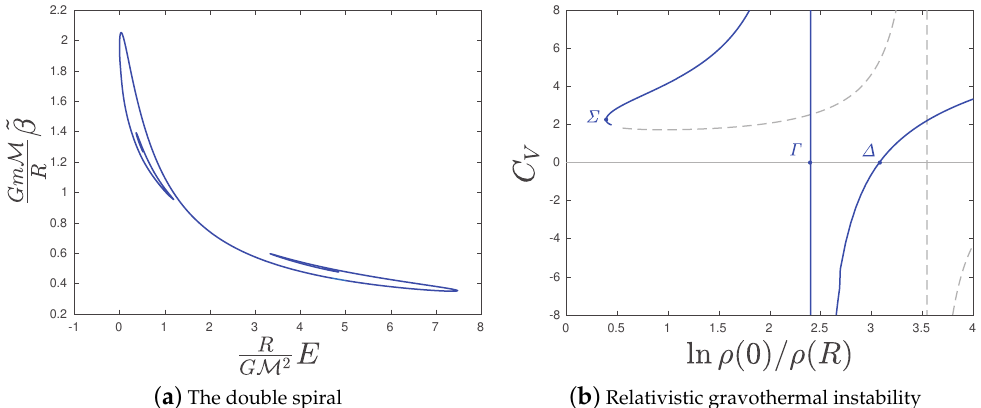
Figure 2. ( a ): The caloric curve of the classical ideal gas for rest mass compactness ξ = 0.25. The upper spiral designates the low-energy gravothermal instability and the lower spiral the high-energy gravothermal instability. The figure is taken from [7]. ( b ): The specific heat w.r.t. the density contrast for ξ = 0.1. The high-energy gravothermal instability sets in at point ∆ when the specific heat passes from negative, corresponding to stable equilibria, to positive values. At point Σ , the density contrast attains a minimum. The dashed curve corresponds to the spiral of the low-energy gravothermal instability, that is the upper spiral of the left panel. The figure is taken from